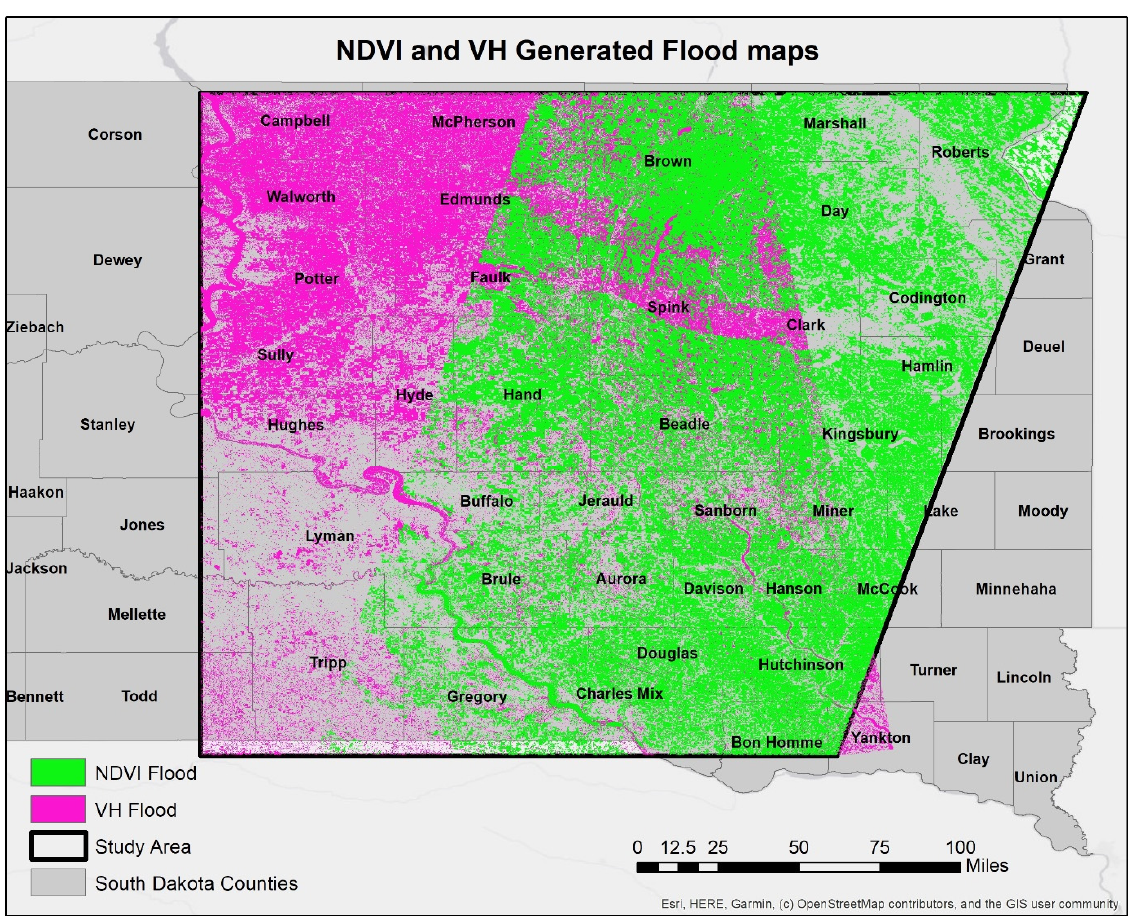
Figure 13. Overlay of NDVI and VH generated flood maps showings areas of overlap and fringes without overlap.